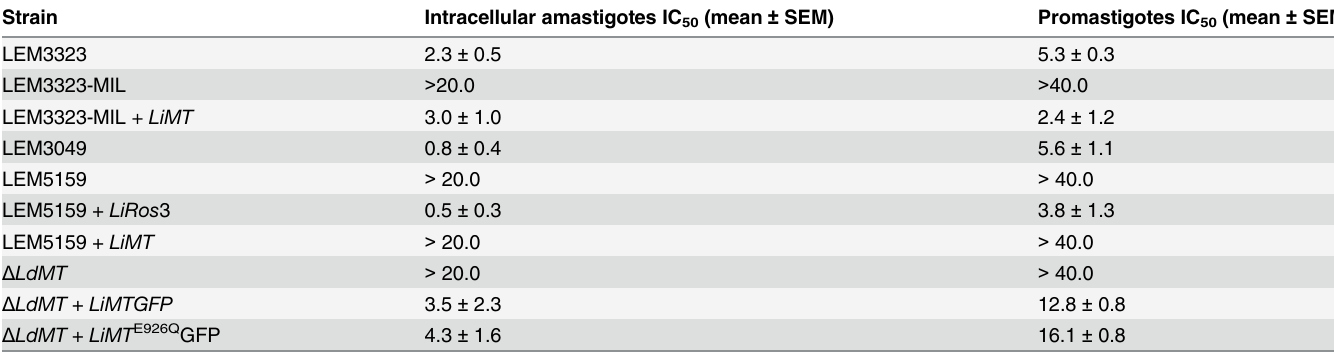
Table 1. Susceptibility to miltefosine (MIL) of the different L . infantum strains.